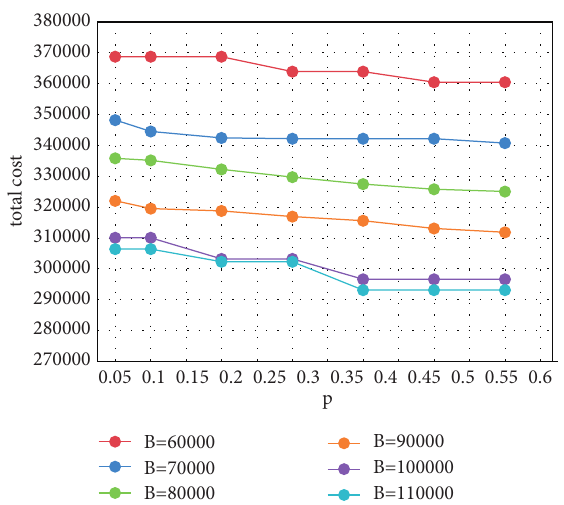
Figure 7: The changing procedure of total cost according to p and B for Model 1.